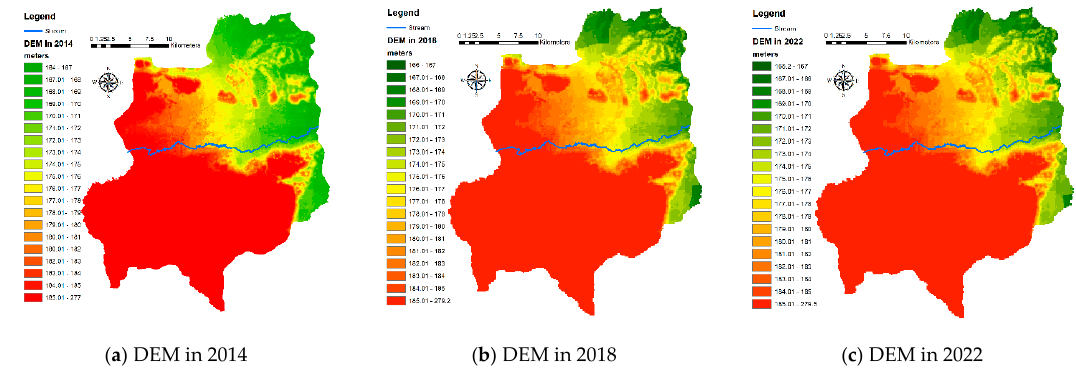
Figure 5. Maps of DEM in ( a ) Year 2014, ( b ) Year 2018 and ( c ) Year 2022. Figure 4. Maps of DEM in ( a ) Year 2014, ( b ) Year 2018 and ( c ) Year 2022. Table 3. DEM change impact to basic hydrological